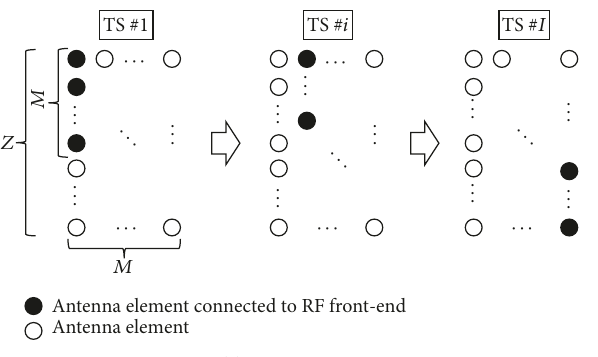
Figure 4: TS transmission